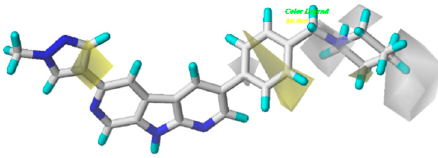
Figure 6. Hydrophobic contours of the CoMSIA model. The yellow color shows the favored hydrophobic area, the white color shows the disfavored hydrophobic area.